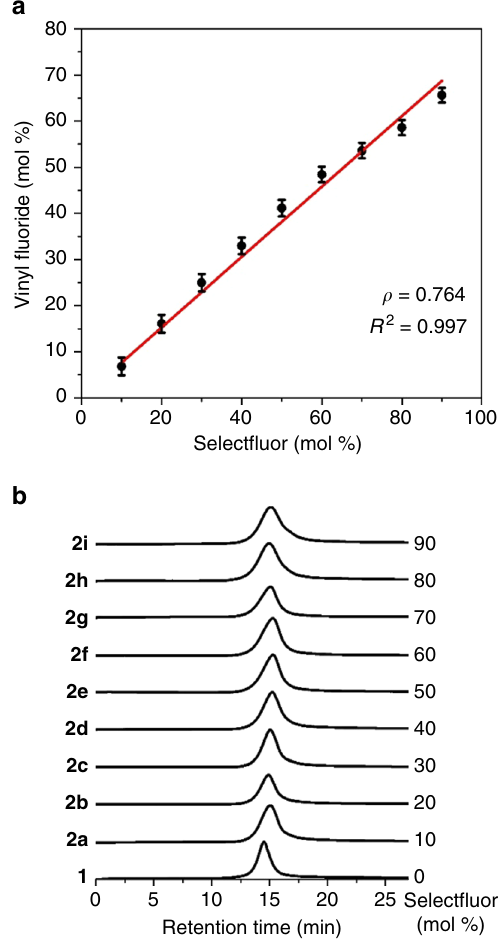
Fig. 1 Controlled decarboxylative fl uorination of poly(acrylic acid) 1 in water. a The dependence of the molar percentage of vinyl fl uoride in copolymers 2 on the molar amount of Select fl uor. b GPC (DMF)